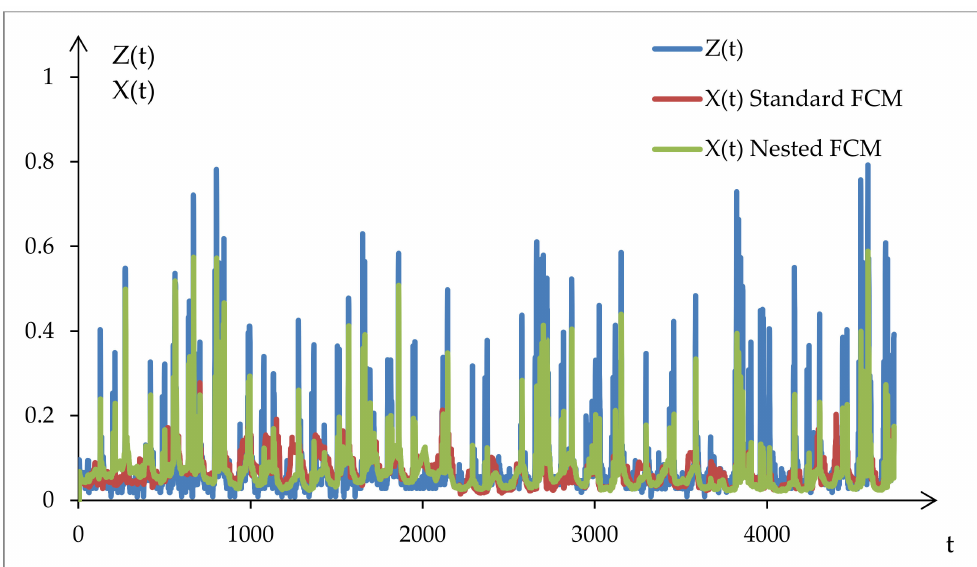
Figure 4. Forecasting results for the best model obtained with the use of the SOGA